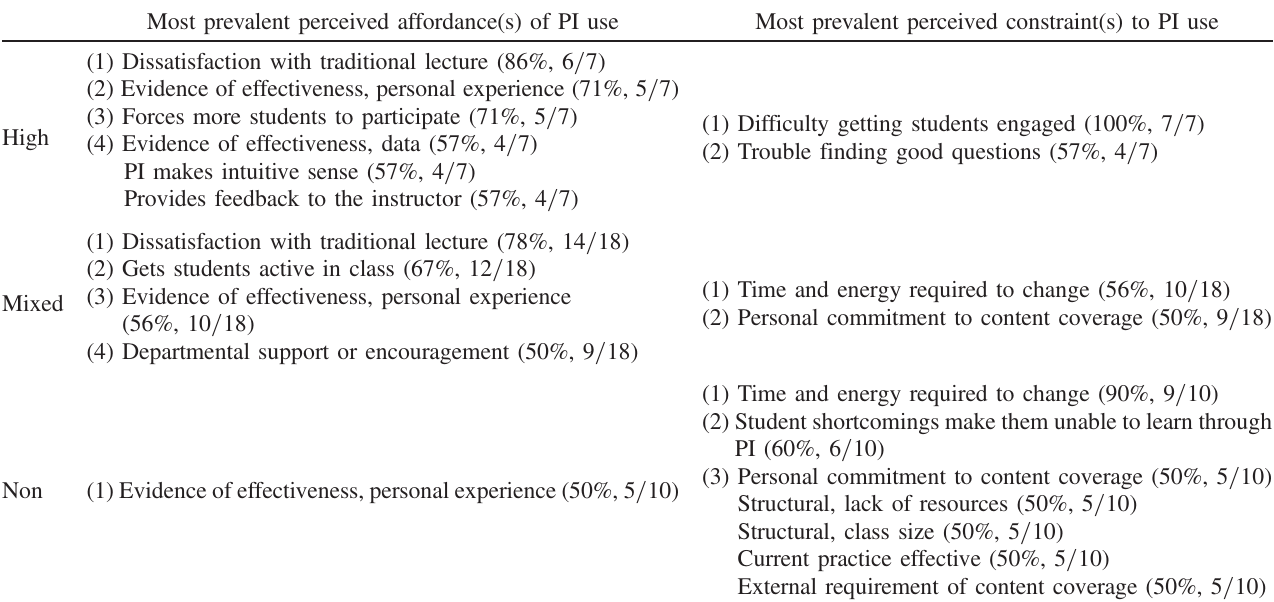
TABLE V. Most prevalent reasons given for aligning or not aligning instructional practices with PI by researcher-assigned user group. Reasons are shown in this table only if the reason was cited by 50% or more of participants within the user group. Most prevalent perceived affordance(s) of PI use Most prevalent perceived constraint(s) to PI use